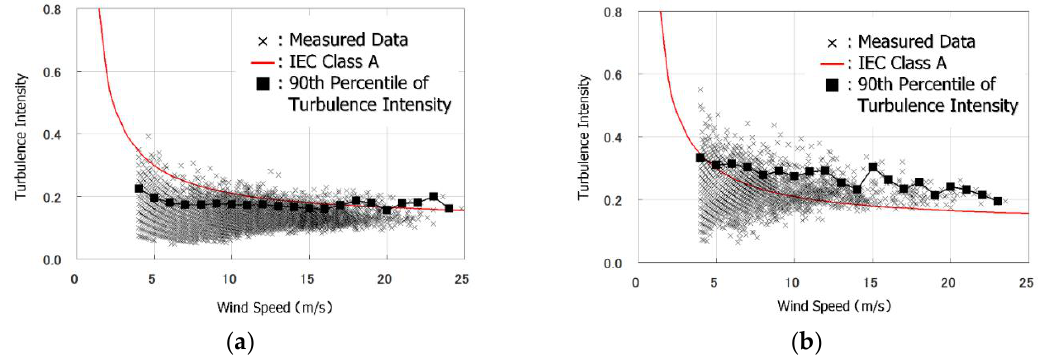
Figure 4. Turbulence intensity (TI) as a function of the 10 min mean wind speed of the No. 2 wind turbine from April 2016 to March 2017 when the wind was ( a ) NNW (north-northeast wind) and ( b ) ESE (east-southeast wind).